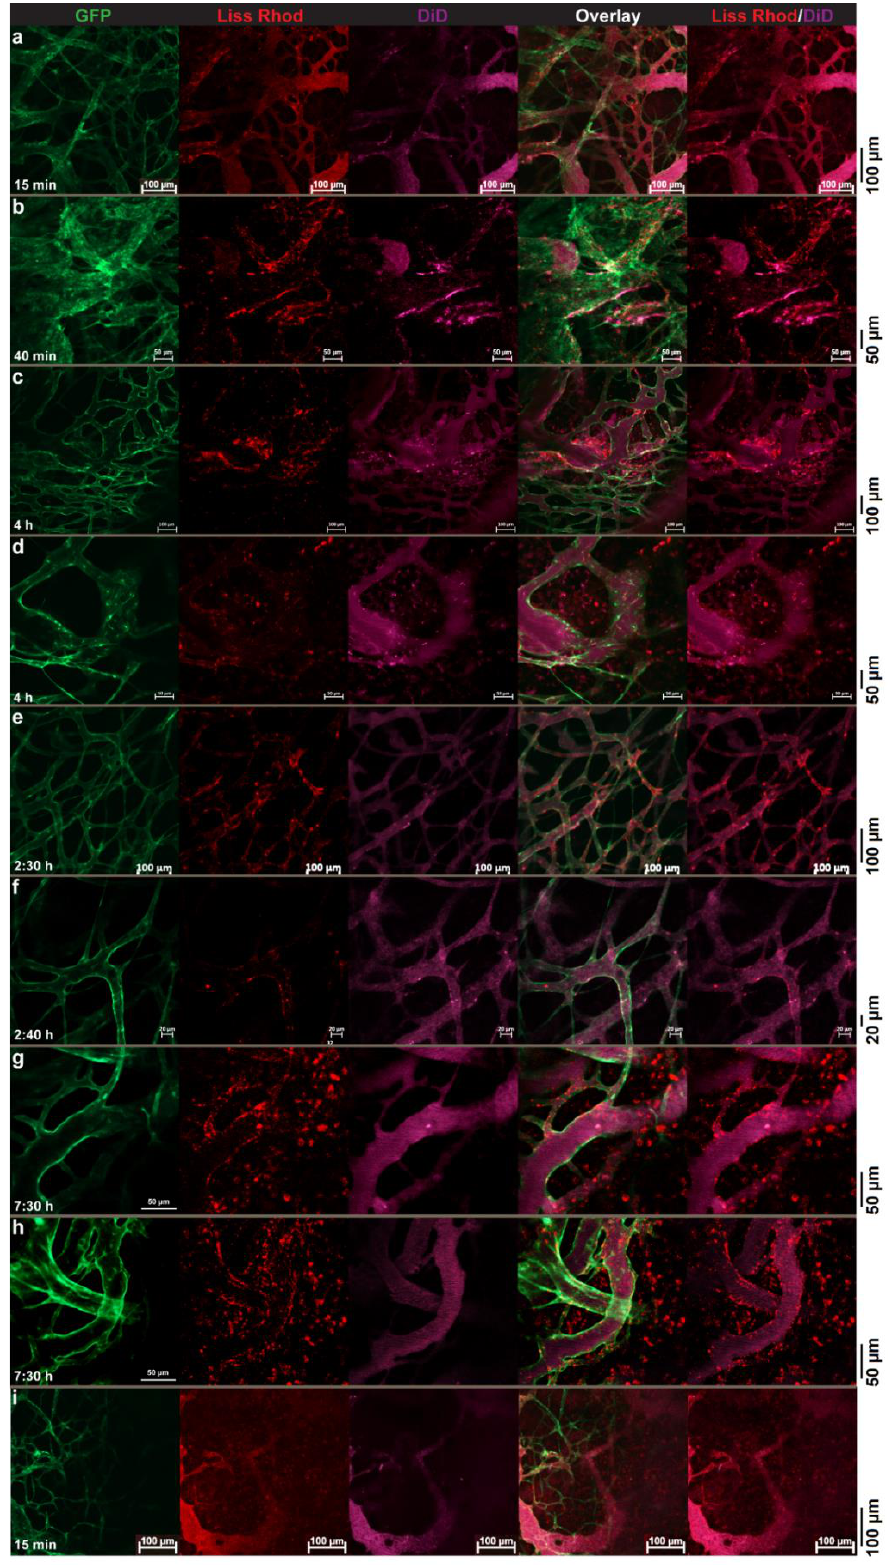
Figure 7. Intravital microscopy of intratumor behavior of Rho-PE-labeled (red) dually targeted liposomes (D32-FPL) mixed and injected with DiD-labeled RGD-liposomes (R3-FPL). While in some regions both liposomal preparations represent identical vascular targeting ( a , b ) in more captured images ( c – h ) D32-FPL exhibits superior vascular targeting compared to R3-FPL that in some regions failed to interacts with tumor vessels ( g – h ). Images ( g – i ) show cellular association of extravasated